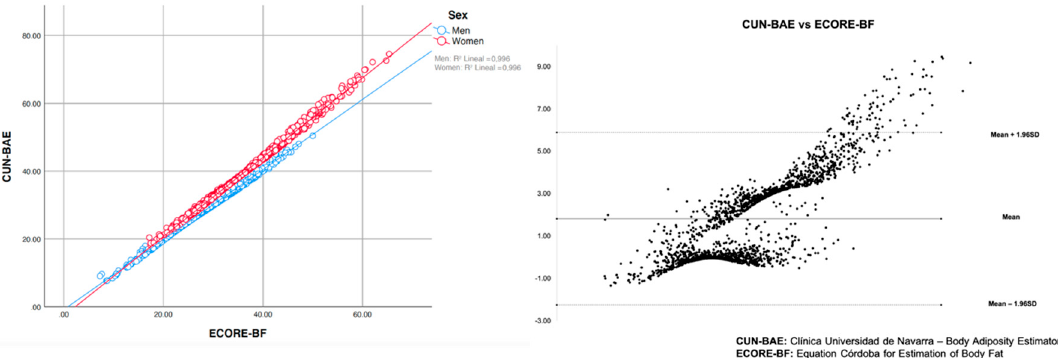
Figure 2. Validation of the proposed model (ECORE-BF: Equation Córdoba for Estimation of Body Fat).